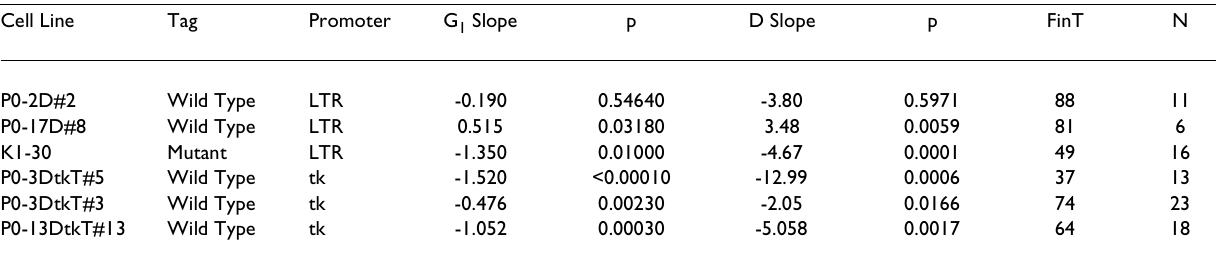
Table 1: Tag change during exponential growth (G 1 ) and at high cell density. 1 Cell